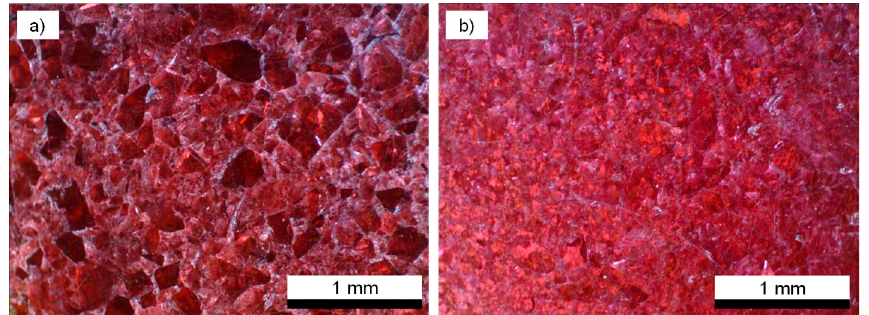
Figure 4. Images of the Co 2 Al–NO 3 samples in nonpolarized light: the pressed compact of the LDH powder precipitated in an external magnetic field and then dried without mixing ( a ) and the pressed compact of the LDH powder dried after centrifugation ( b ).